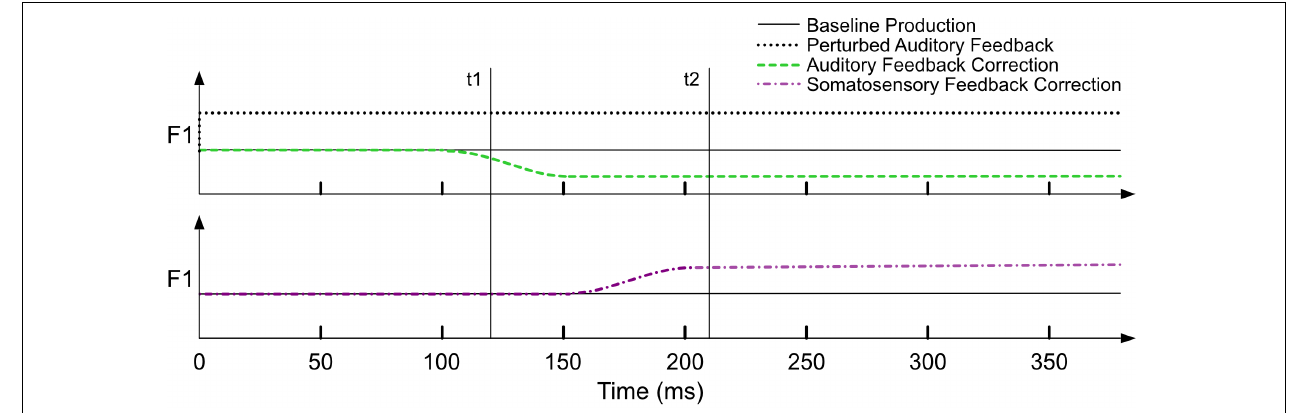
FIGURE 2 | A schematic of the time-course of a single perturbed trial within a sensorimotor adaptation paradigm. The upper panel shows the auditory domain: the auditory perturbation is applied from the beginning of the trial, and the auditory feedback-based correction is evident ∼ 100 ms post-perturbation onset. The lower panel shows the somatosensory domain: somatosensory feedback-based correction is evident ∼ 50 ms following auditory feedback-based correction. Across panels, the vertical lines (t1, t2) indicate that the contribution of auditory versus somatosensory feedback control varies depending on when the acoustic measurement of F1 is made within a